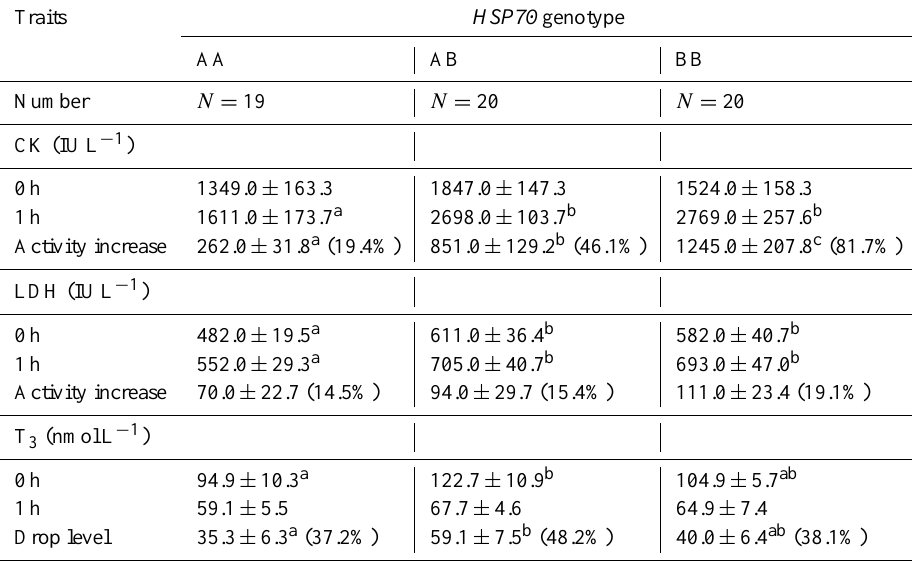
Table 1. The effect of HSP70 genotypes on enzyme activities and T 3 levels in the plasma of the LRI native chickens at 40 ◦ C ambient temperature.